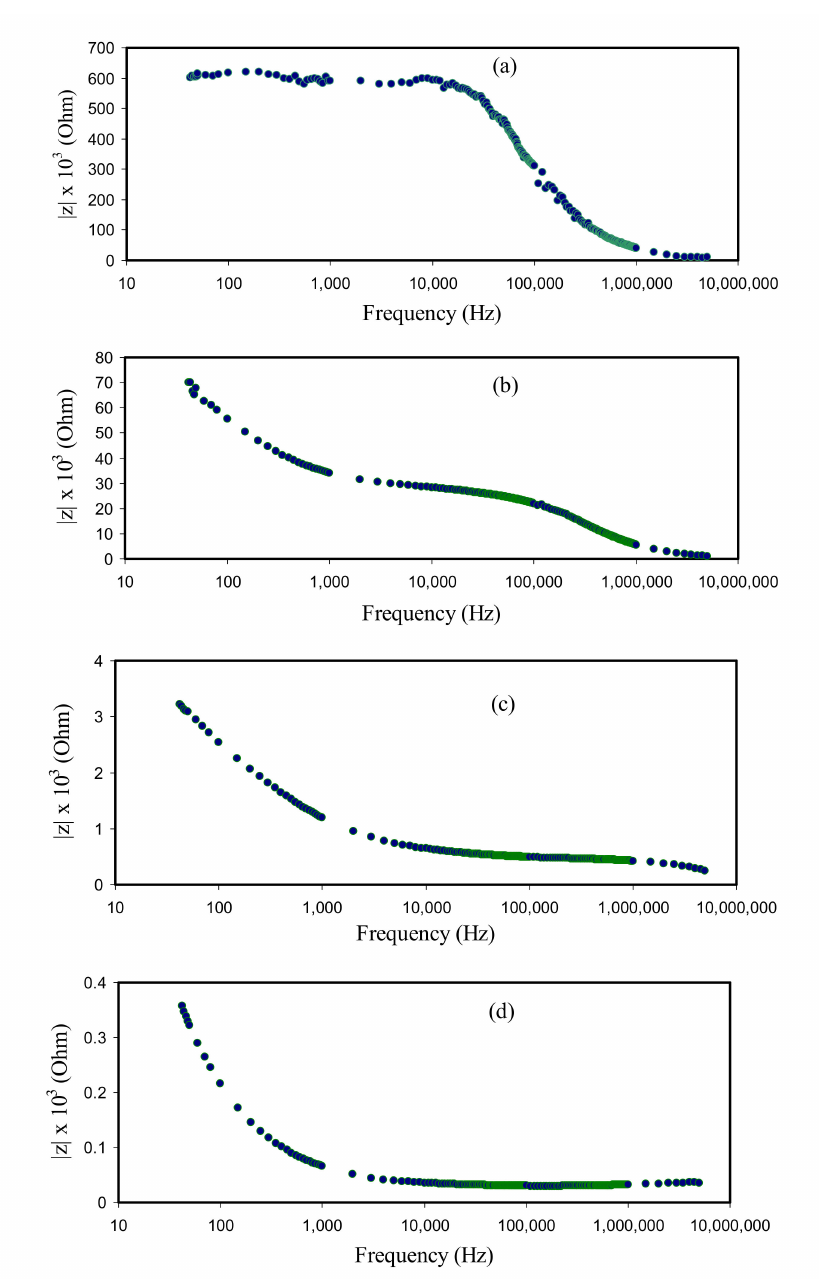
Figure 7. Bode plots of NCSPEs at room temperature for ( a ) CSAG1, ( b ) CSAG2, ( c ) CSAG3, and ( d )